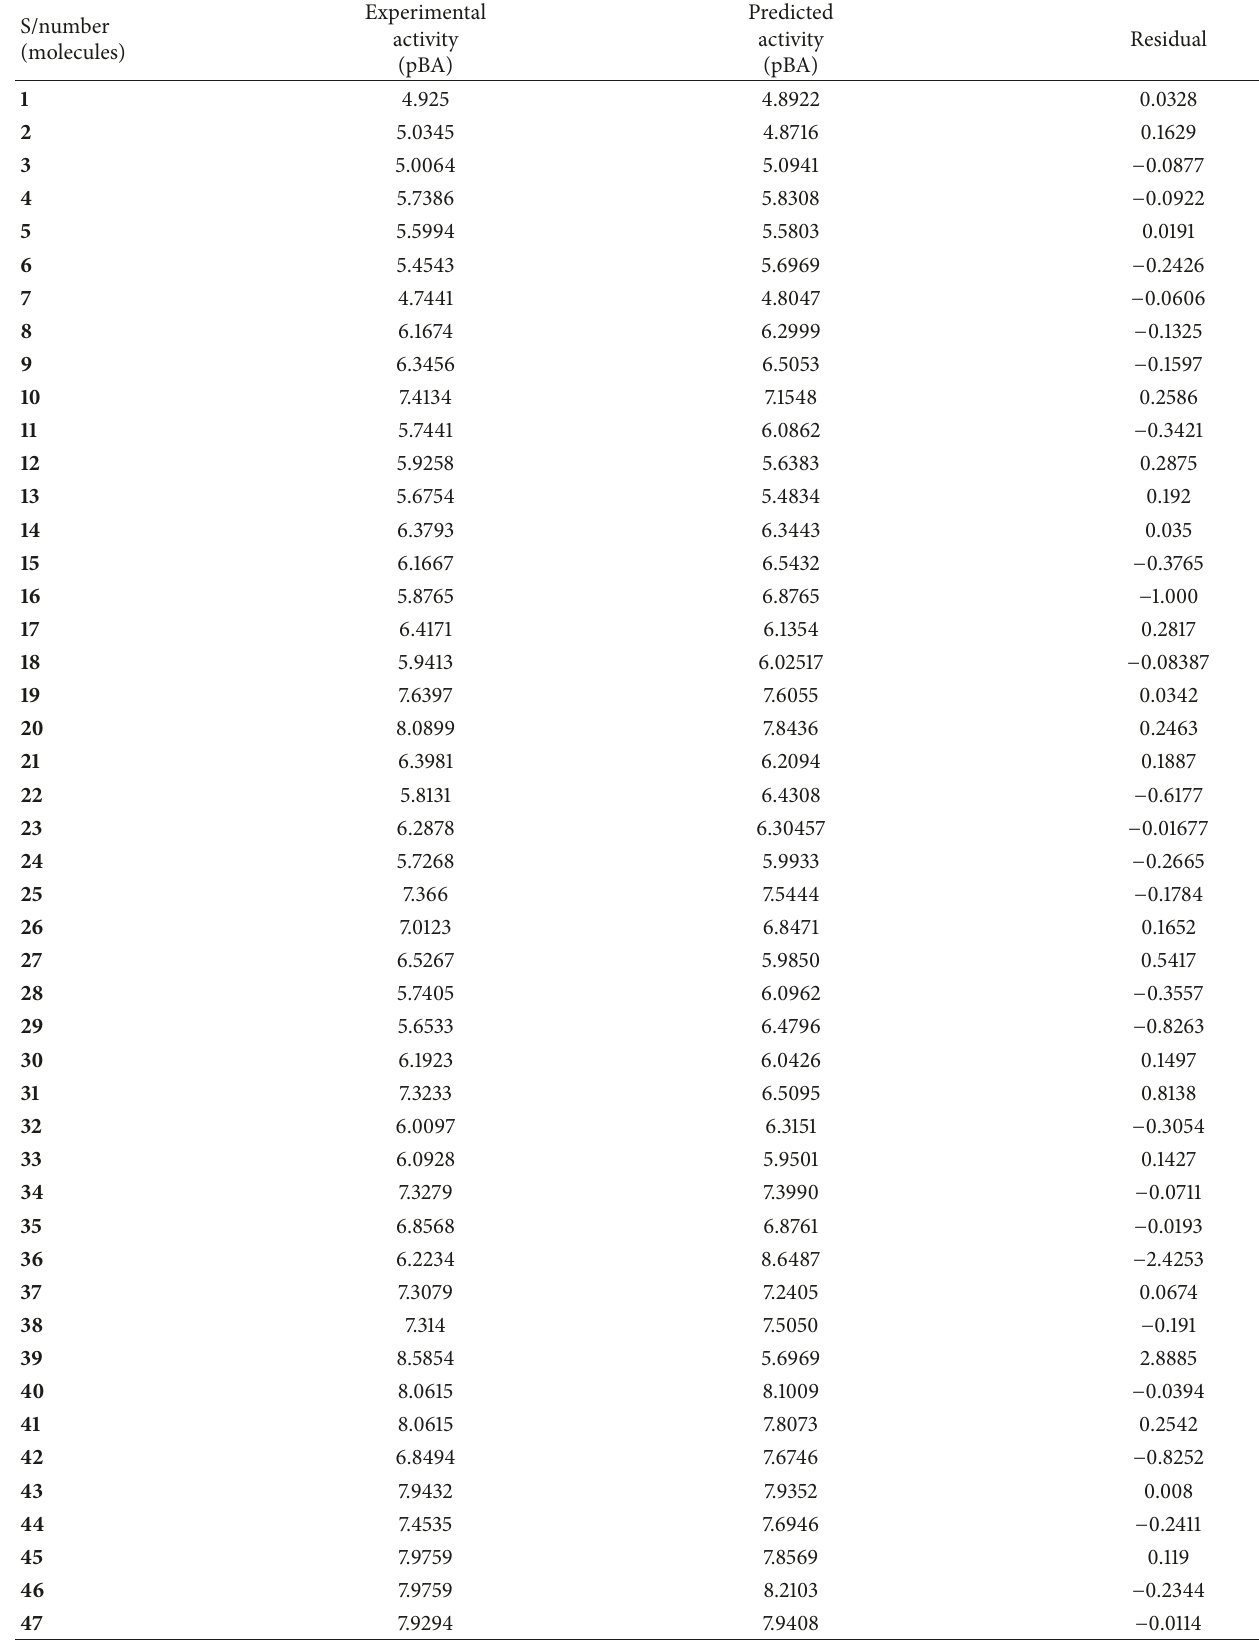
Table 3: Experimental, predicted, and residual values for 1,2,4-Triazole